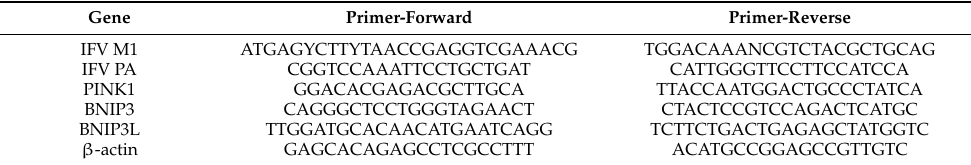
Table 1. Primer sequences used in this study.